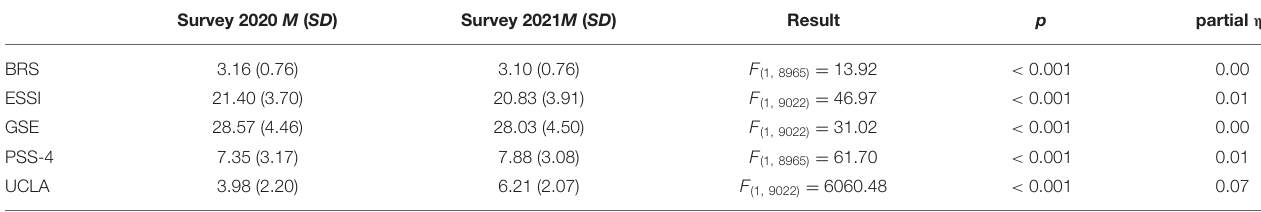
TABLE 2 | Mean scores of instruments measuring social and emotional aspects and mean differences between the two